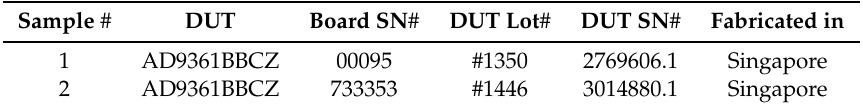
Table 3. DUT sample information.